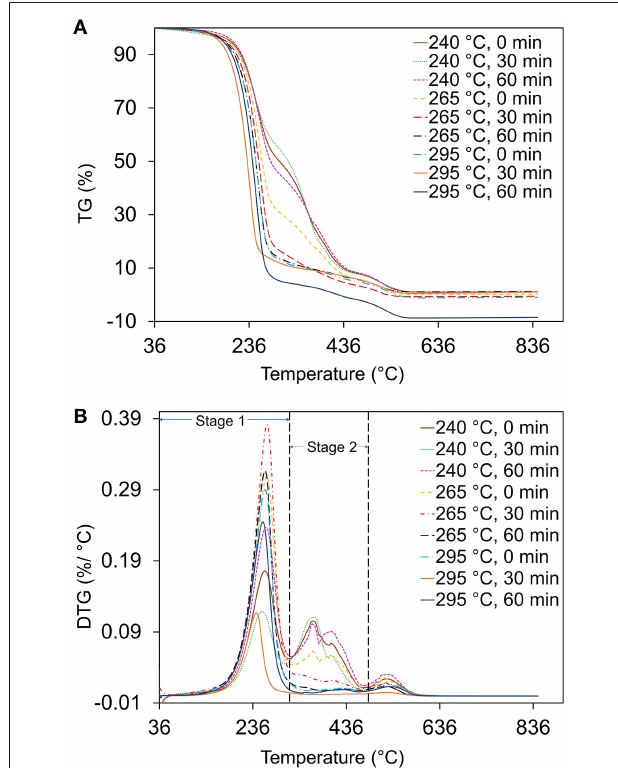
FIGURE 2 | (A) Thermogravimetric analysis (weight loss) and (B) differential thermogravimetric analysis (weight loss rate) of bio-crude oils derived from hydrothermal liquefaction of food waste under different temperature and reaction time conditions. Analysis was conducted under an air